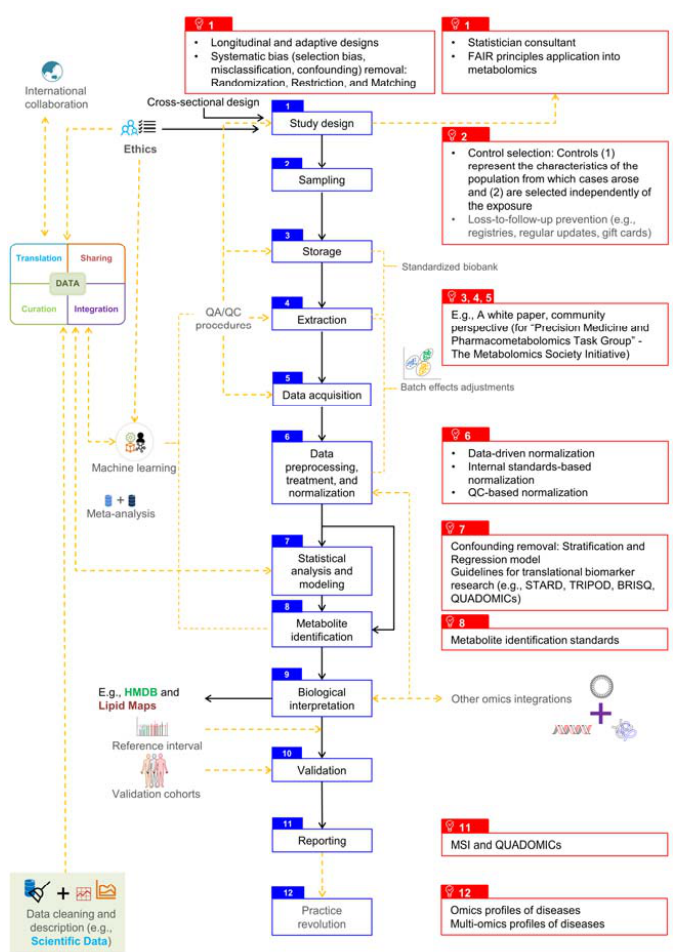
Figure 1. The standard untargeted metabolomics workflow at clinical and epidemiological scale. Blue boxes constitute the backbone of the workflow. Black arrows indicate current standards. Orange dashed arrows imply that the issues have been raised but have not received enough attention or have lacked communication. Red boxes represent current and / or potential solutions to these issues. BRISQ: